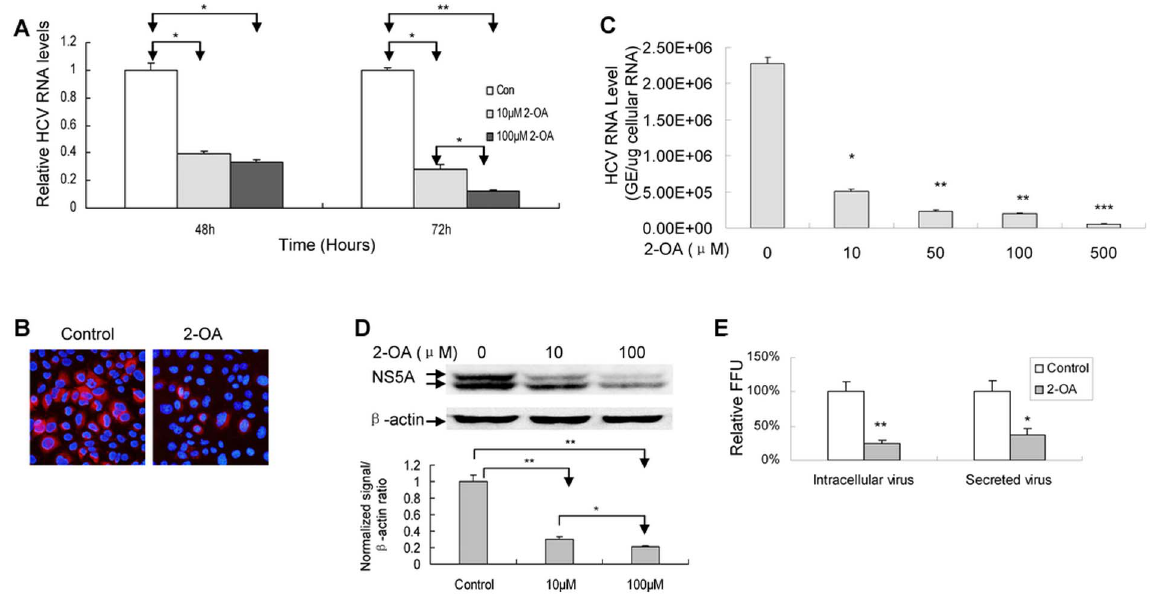
Figure 3. 2-OA inhibits HCV infection in infectious cell culture system. ( A ) / ( B ) 2-OA inhibits HCV replication in JFH1 RNA-transfected Huh7.5 cells. Huh7.5 cells were transfected with in vitro transcribed JFH1 RNA. ( A ) The cells were treated with 10 m M and 100 m M 2-OA for 48 and 72 hours. HCV RNA was detected with real-time PCR and normalized with GAPDH. ( B ) The cells were treated with 100 m M 2-OA for 48 hours and immunostained with mouse monoclonal anti-NS5A antibody (red). DAPI was used for nuclear counterstaining (blue). Identical settings were maintained for image capture. Representative images are shown. ( C ) Huh7.5 cells were infected by JFH1 virus at MOI of 0.1 in the presence of different doses of 2-OA for 72 hours. Intracellular HCV RNA was analyzed by real-time PCR and displayed as genome equivalents (GE)/ m g total cellular RNA. ( D ) Huh7.5 cells were infected by JFH1 virus at MOI of 0.1 for 2 days and treated by 2-OA for 72 hours. NS5A protein was detected with western blot analysis (upper) and quantified by densitometry in comparison with b -actin (lower). ( E ) Huh7.5 cells were infected with JFH1 virus at MOI of 0.1 and treated by 100 m M 2-OA for 72 hours. The extracellular or intracellular virus was titred. The infectivity titers in the supernatant or cell lysates were normalized to that of control from three independent